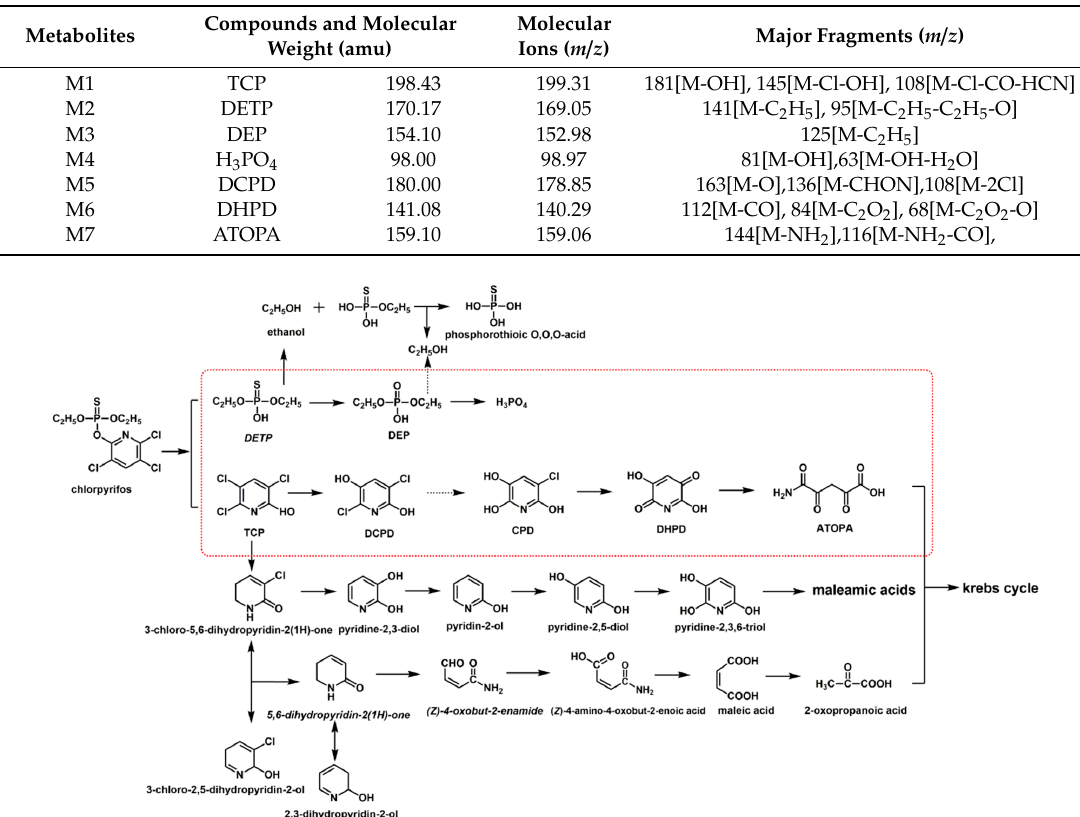
Table 2. Analysis of metabolites of chlorpyrifos in strain X1 T by LC-MS / MS.